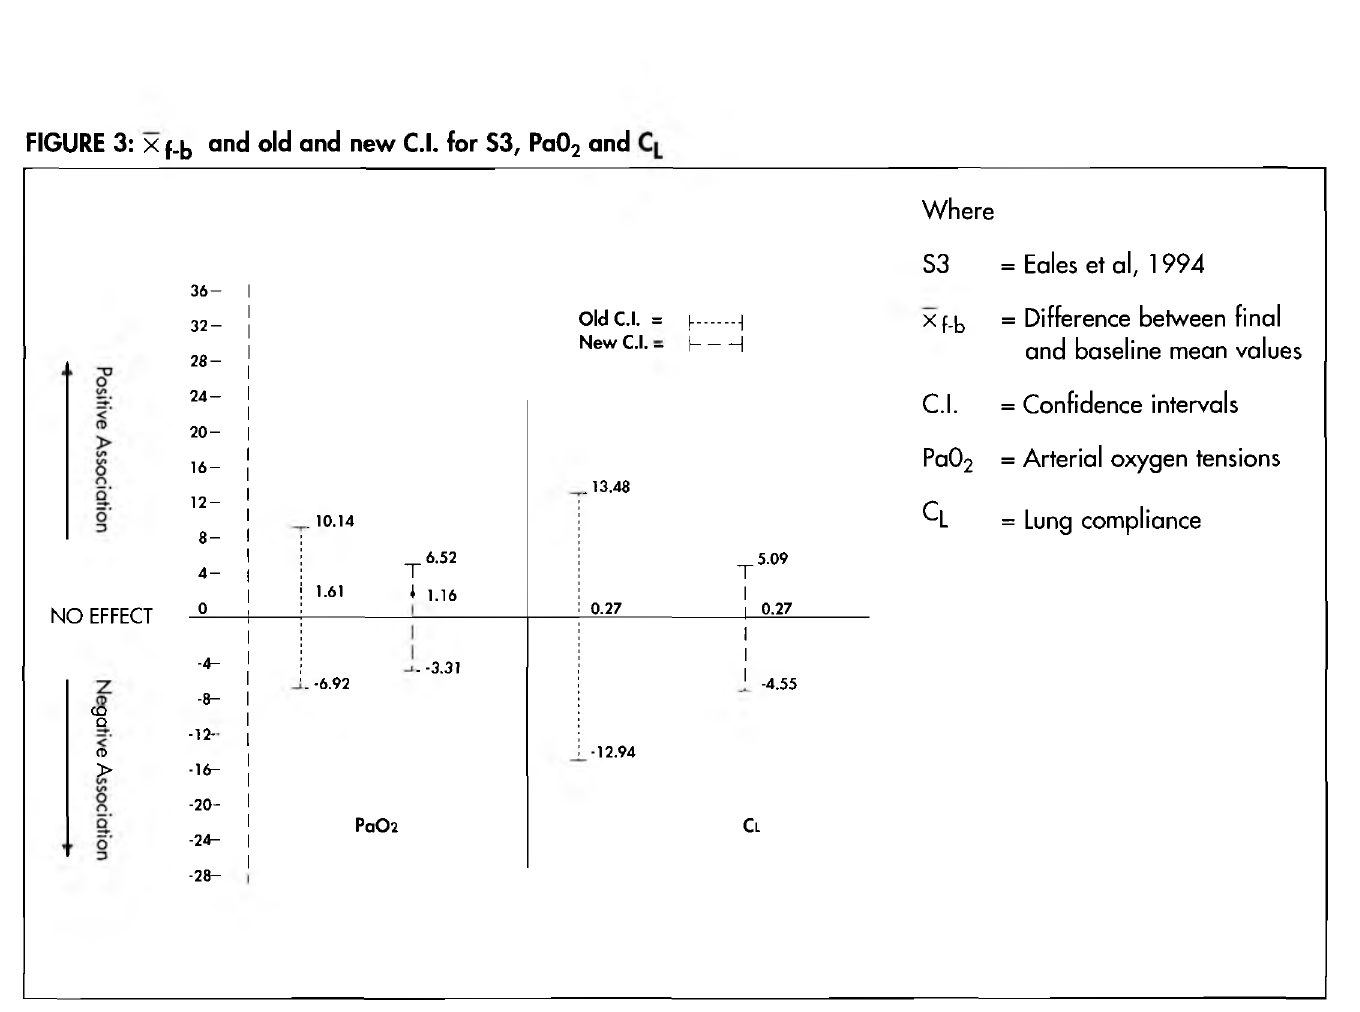
FIGURE 3: X f_b and old and new C.I. for S3, Pa02